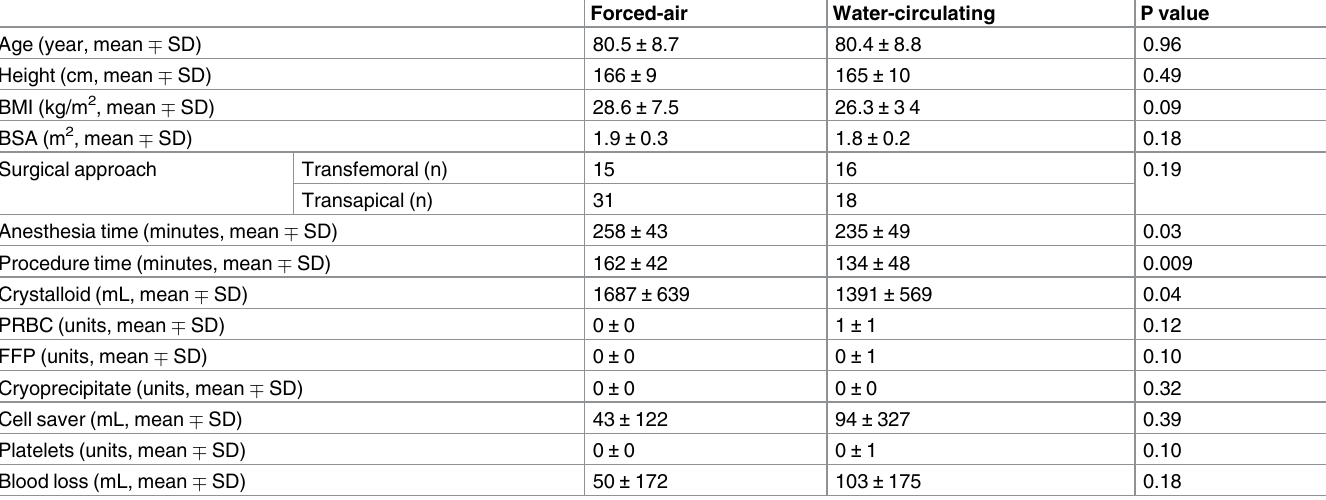
Table 1. Demographic characteristics and intraoperative